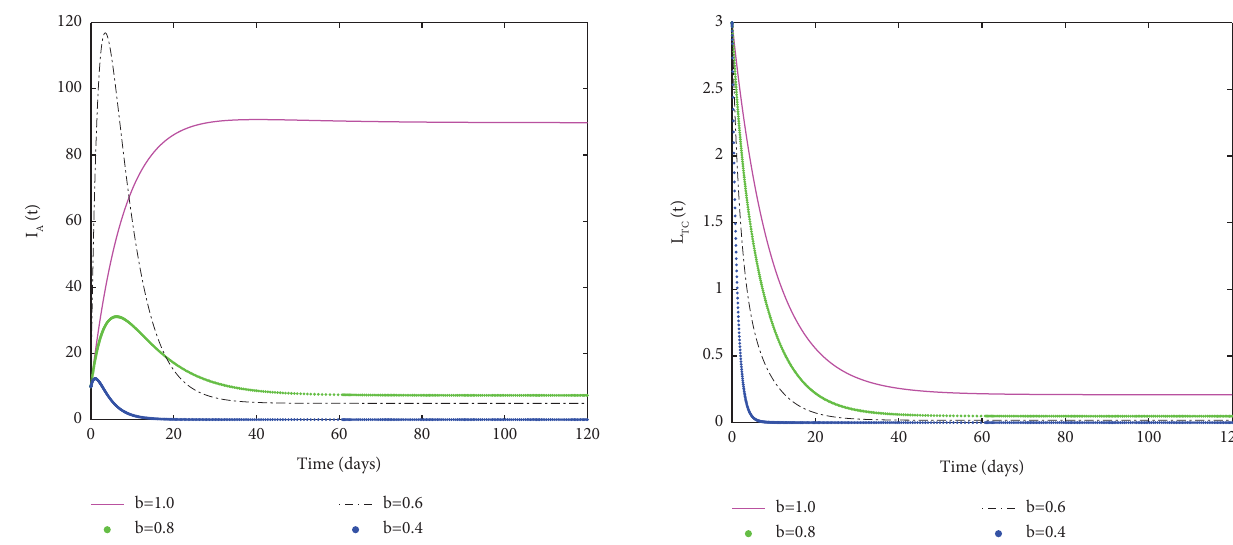
Figure 7: Behaviour of the latent TB-COVID-19 coinfected in- dividuals at diferent values of b .